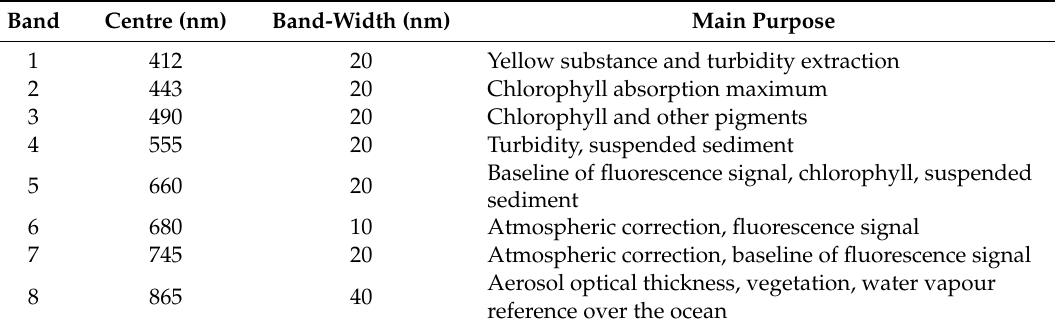
Table 1. GOCI spectral bands